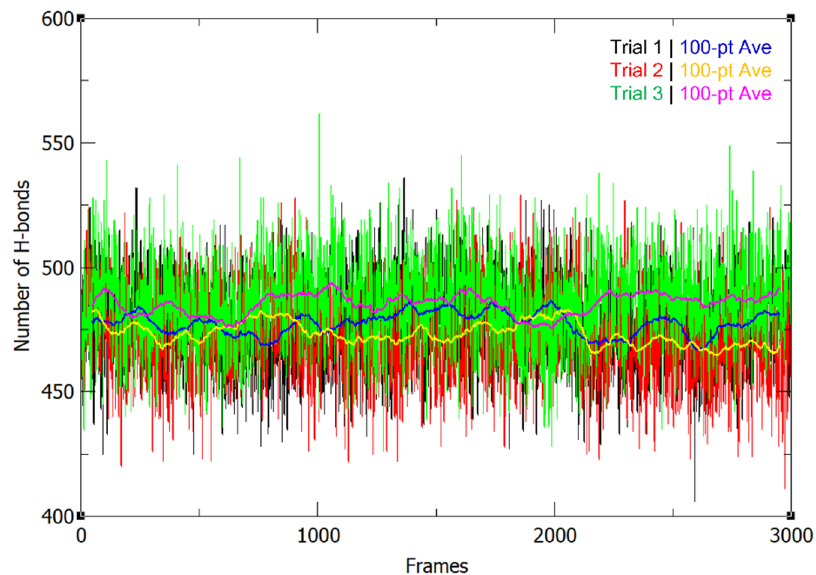
Figure 1. ( a ) Backbone RMSD plot of the three 300 ns dengue NS5 production runs and ( b ) RMSF plot of the dengue NS5 protein chain A and B with trial 1, trial 2, and trial 3 in the first, middle, and last panel, respectively. Table 1. Hydrogen bond donor and acceptor occupancy within the NS5 protein for three production trials. “Main” signifies that the main chain or the backbone participates in hydrogen bonding, while “Side” signifies that the residue side chain participates in hydrogen bonding.